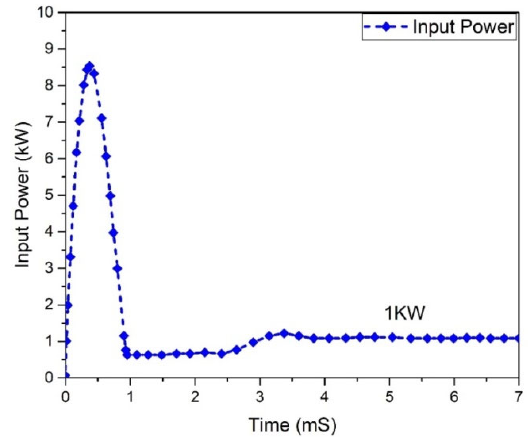
Figure 23. Input power of Flyback boost converter (Si-MOSFET).